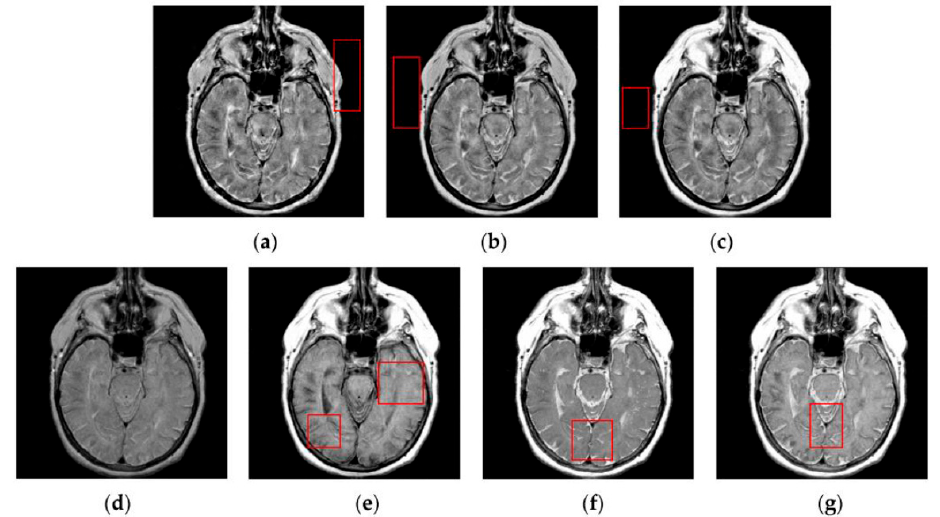
Figure 10. Fused results of the evaluated methods for the fifth group of source images shown in Figures 6i,j: ( a ) the DWT method; ( b ) the NSCT method; ( c ) the NSCT-SR method; ( d ) the m-PCNN method; ( e ) the PCNN-NSCT method; ( f ) the SCM-F method; and ( g ) the SCM-M method.